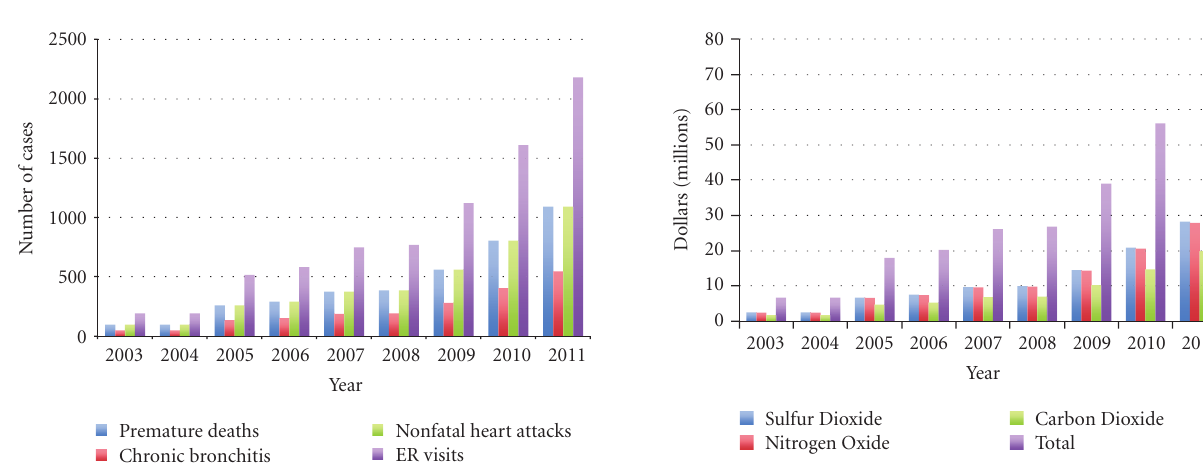
F 5: Health impacts of emissions reduction.